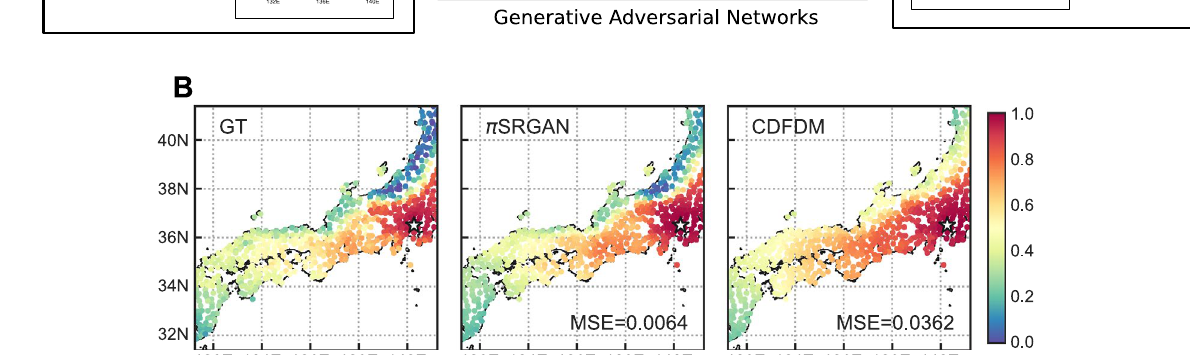
Figure 1. Schematic diagram of π SRGAN and the distribution of spatial correlation coefficients. ( A ) High-resolution topography and low-resolution sea level pressure, in addition to the low resolution data corresponding to the output, are supplied to the generative adversarial networks. ( B ) The reconstructed distributions of spatial correlation coefficients, indicating the correlation strength from the reference site at Tokyo [35.735 ◦ N, 139.6683 ◦ E], obtained with π SRGAN and a conventional CDFDM are compared to the ground truth